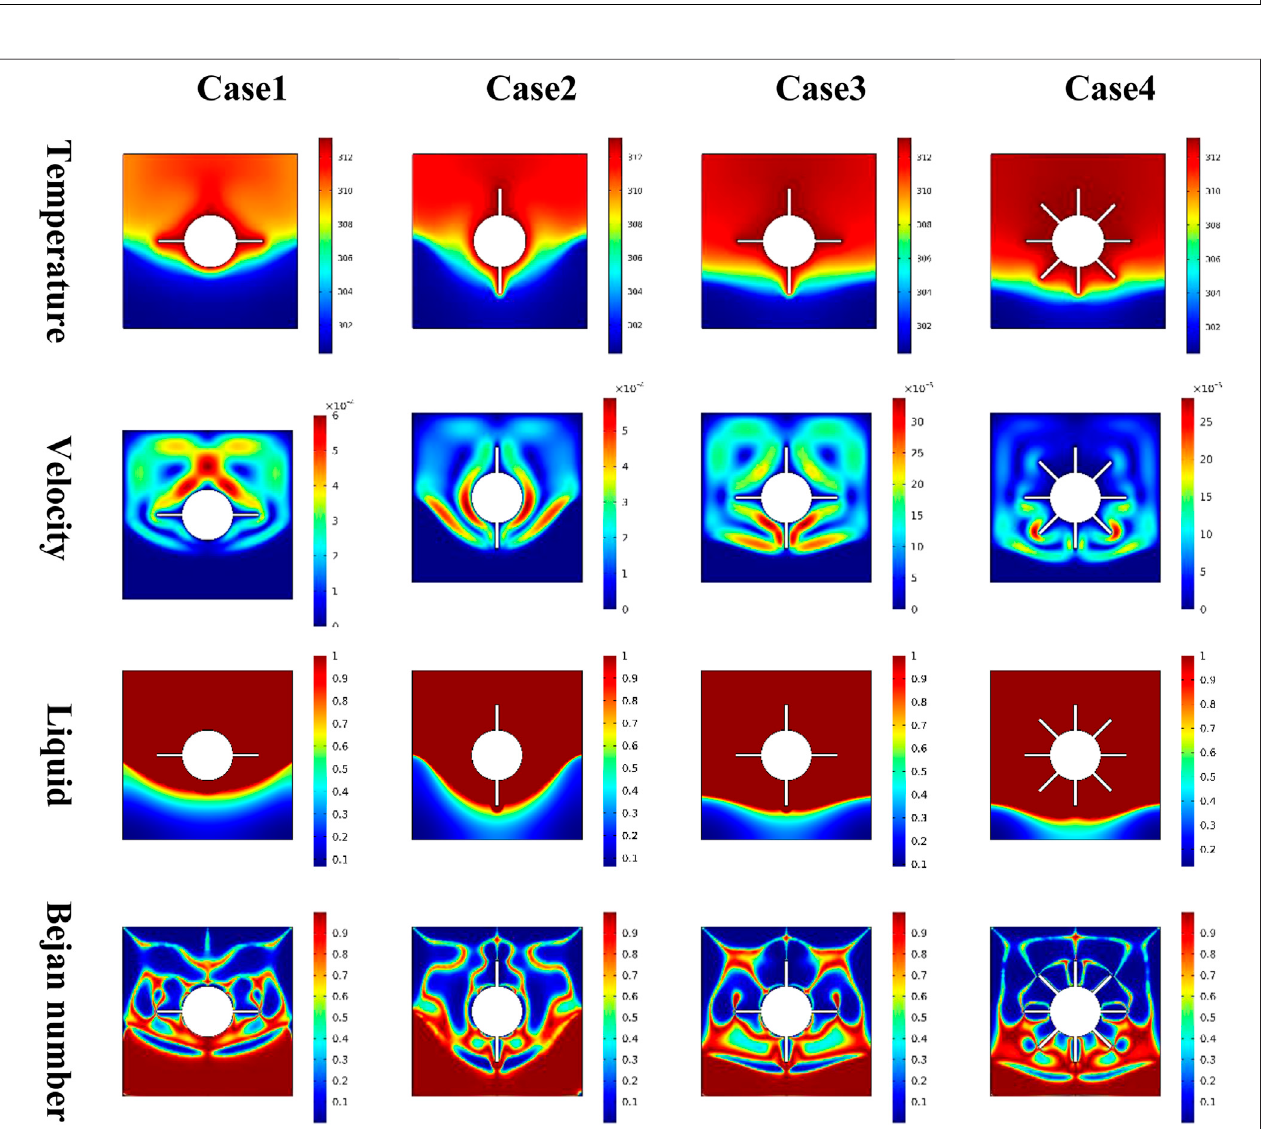
FIGURE 4 | Effect of the number of fi ns, liquid fraction, and Bejan number during the PCM melting process at 500 s.